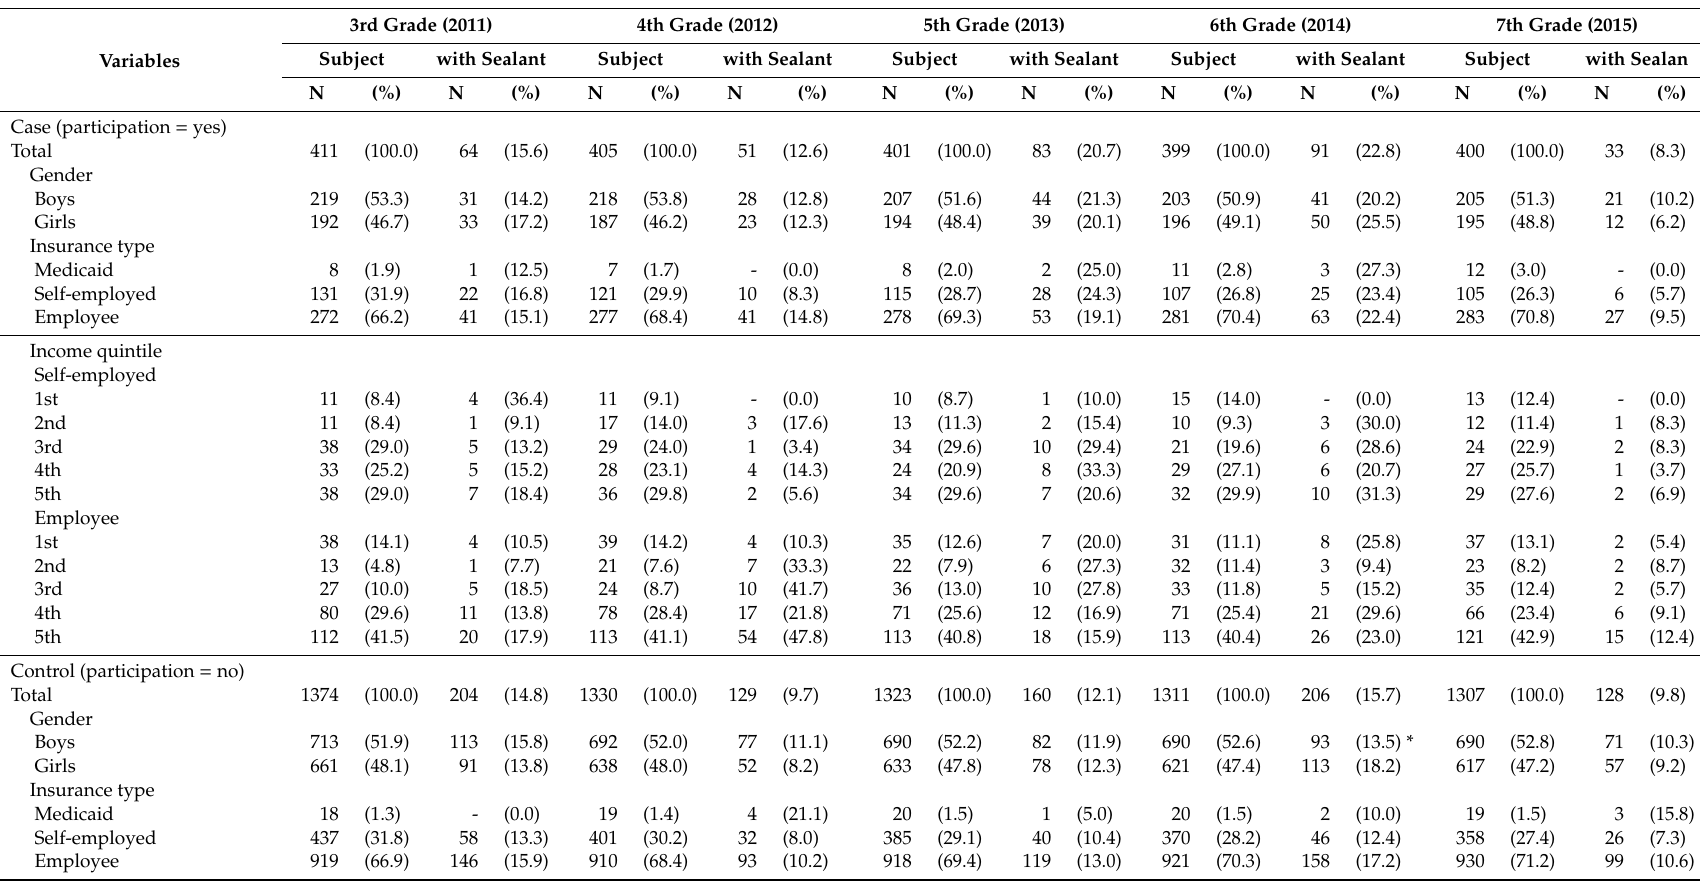
Table 2. The distribution of study sample cohort with dental sealant in the NHISS by